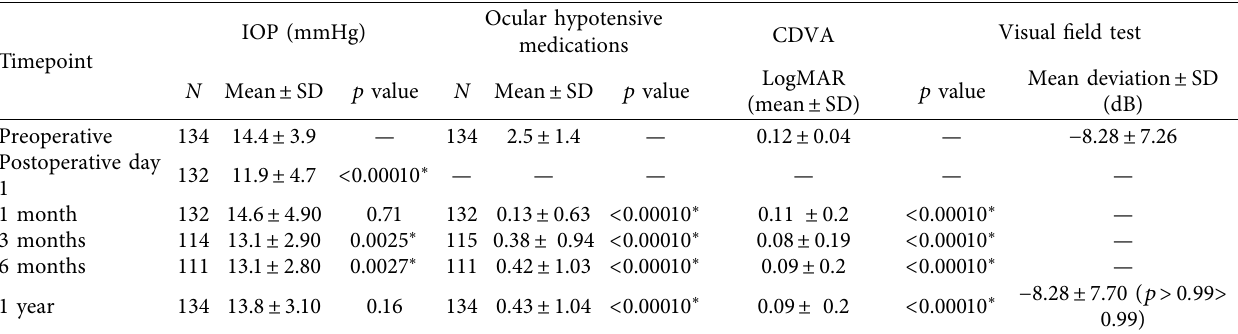
Table 2: Primary outcome measures—IOP, CDVA, number of medications, and mean deviation on visual field at preoperative and follow- up visits for all patients.